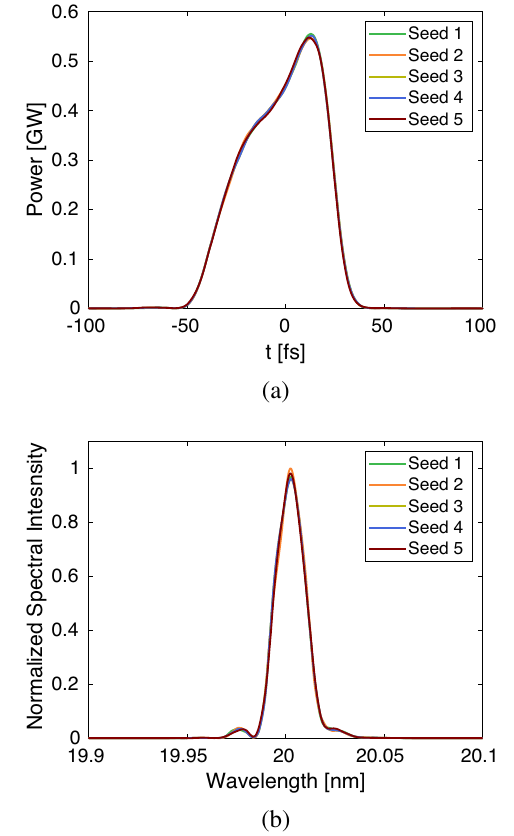
FIG. 9. Shot-to-shot fluctuations for an OK-HGHG setup, imprinted on the output FEL at 20 nm. (a) Power profile for different initial shot noise. (b) Spectra for different initial shot noise. They are normalized to the highest spectral intensity with Seed 3.